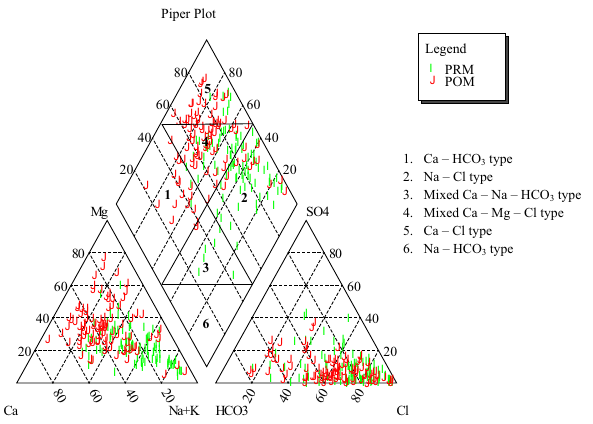
Fig. 3 Piper facies diagram for groundwater samples representing PRM and